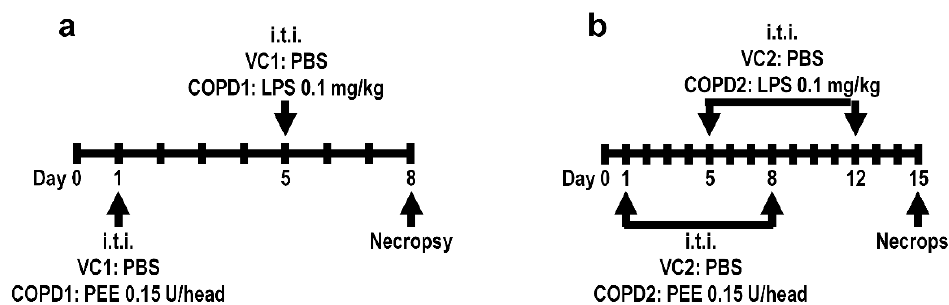
Figure 6. Mouse model experimental schemes. Vehicle control (VC1) and once administration group of PPE and LPS in a week (COPD1) within a week ( a ), and vehicle control (VC2) and two-dose PEE and LPS (doses minimum of one week apart) (COPD2) within two weeks ( b ).